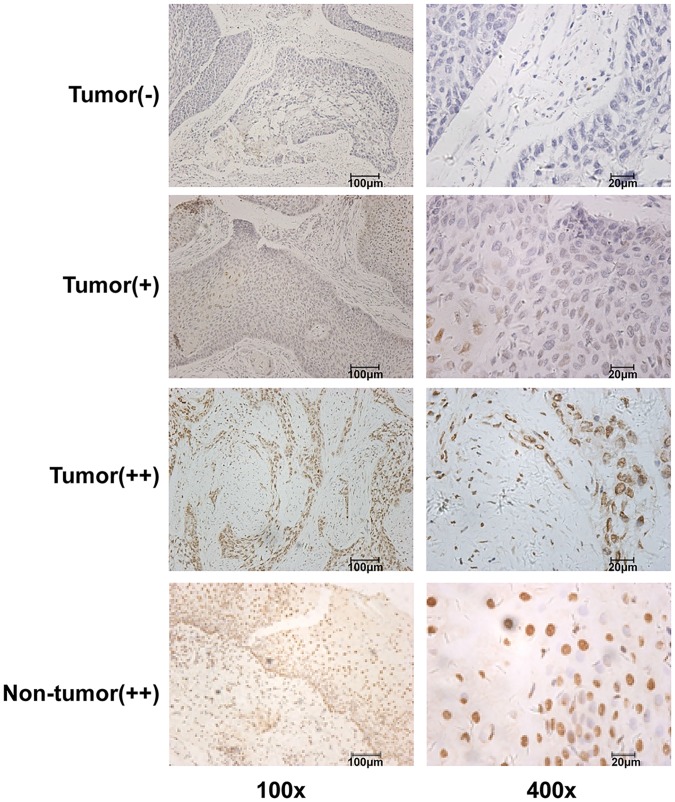
Expression of 5-hmC was decreased in ESCC tissues.Detection of 5-hmC expression in 173 ESCC tissues and 91 corresponding non-tumor tissues using IHC. Representative images are shown (left panel, 100×; right panel, 400×).